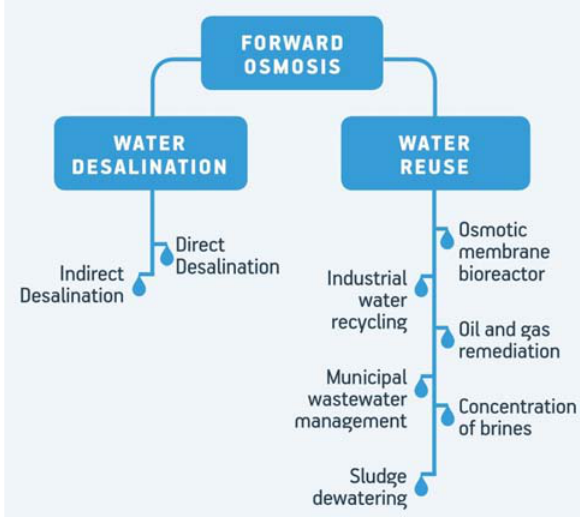
Figure 5. Applications of FO in the water industry, desalination (left) and water reuse (right). 11